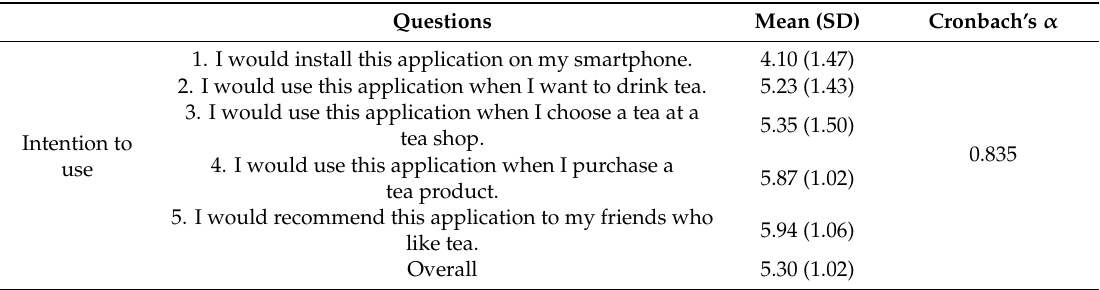
Table 5. Intention to use TeaPick TM